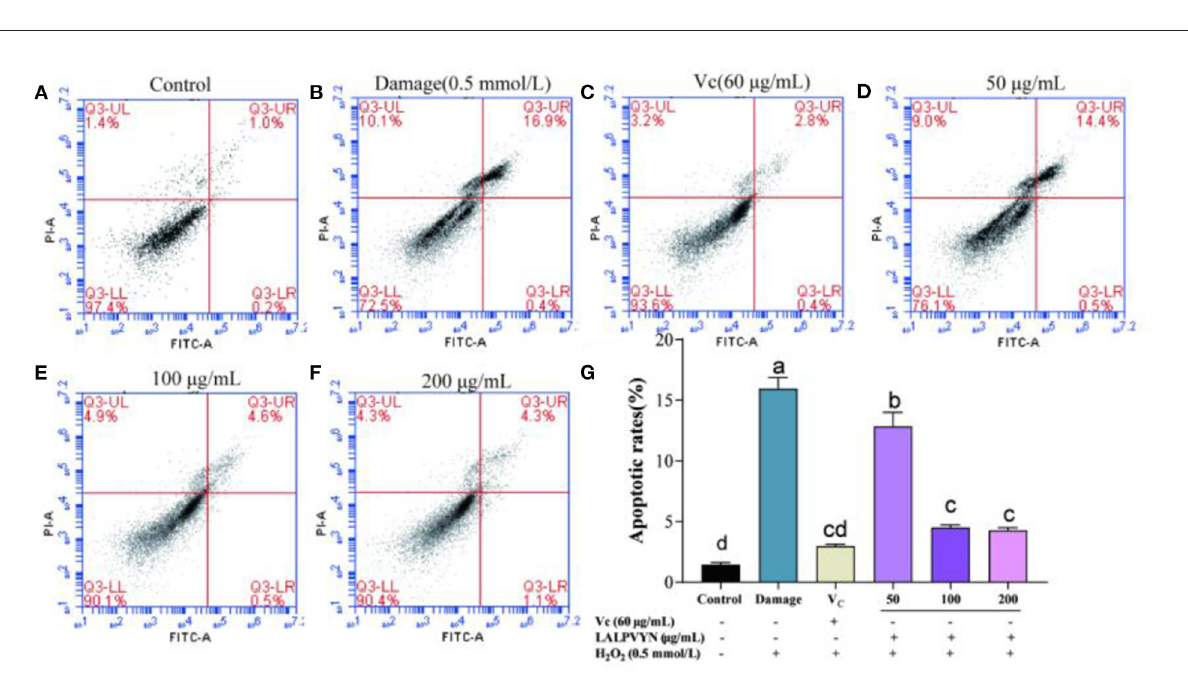
FIGURE7 The effect of LALPVYN pretreatment on apoptosis of H 2 O 2 -mediated oxidative injured HepG2 cells. (A–F) Cell cycle was analyzed by flow cytometry; (G) analysis of apoptotic rate by flowjo software. Data are expressed as mean ± SD from three independent experiments ( n = 3), results marked with the same letters were not significantly different ( P >